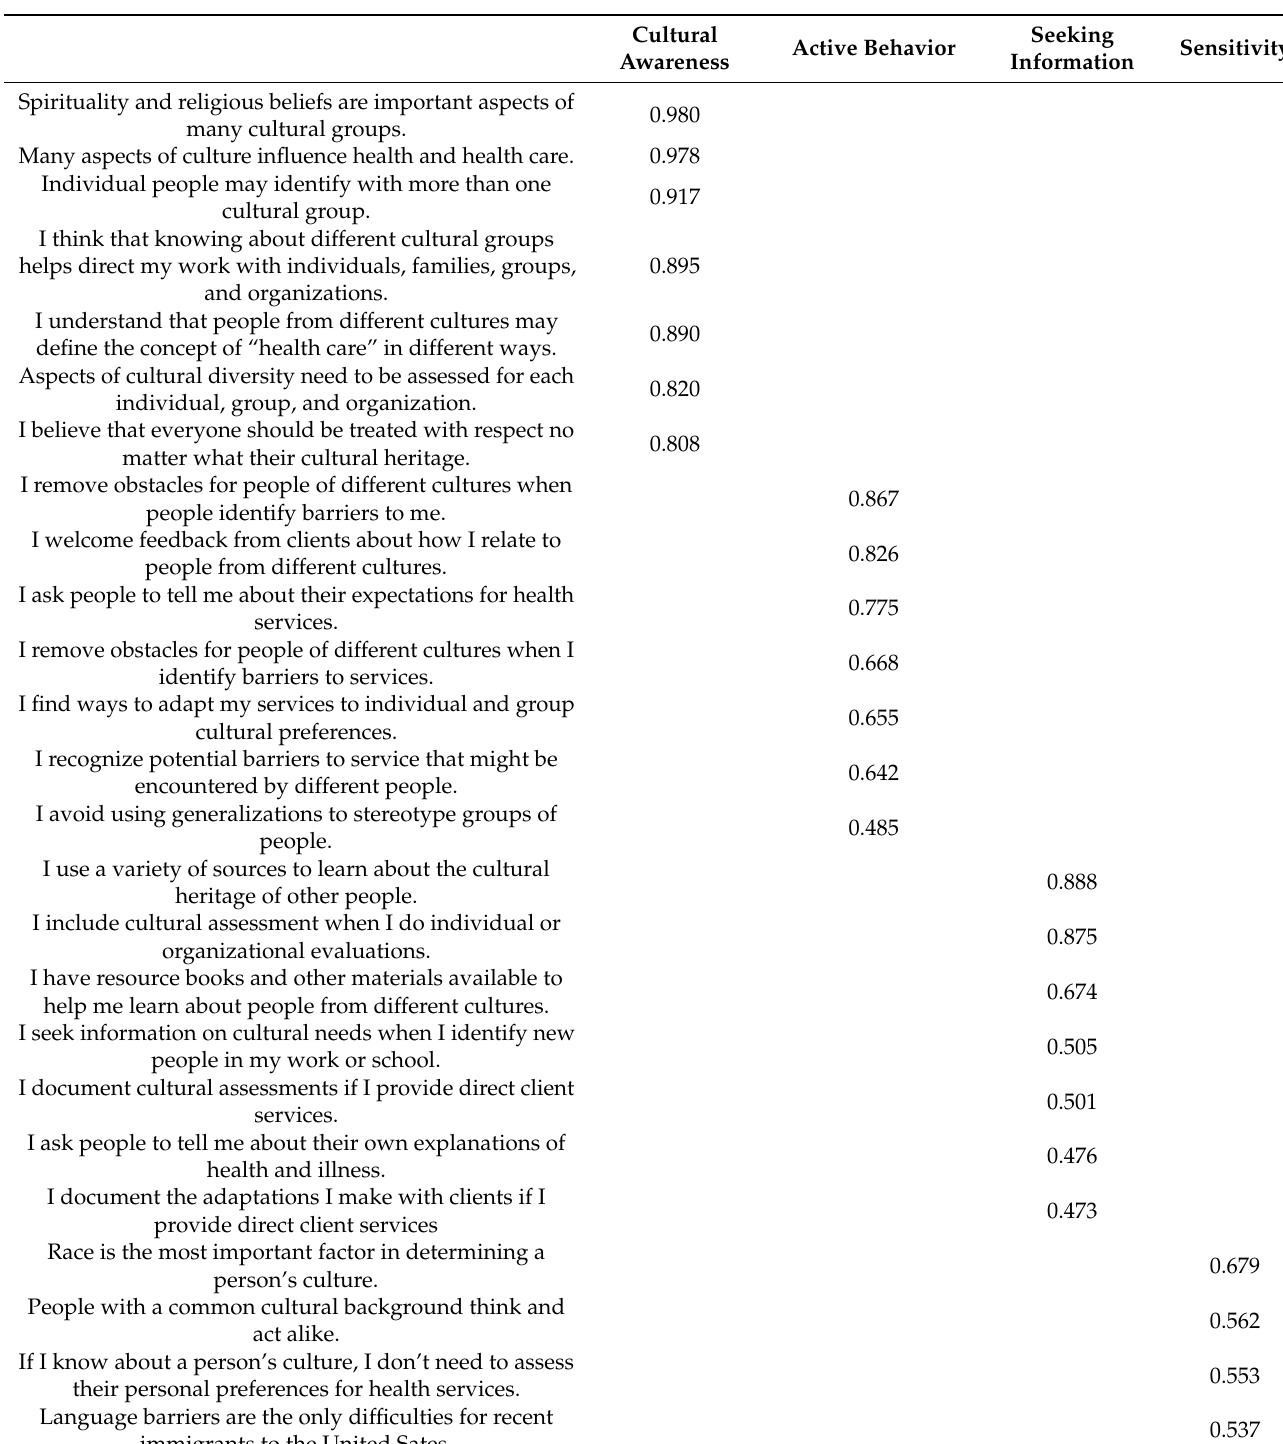
Table 1. Items and their standardized coefficients on the CCA-TR dimensions.